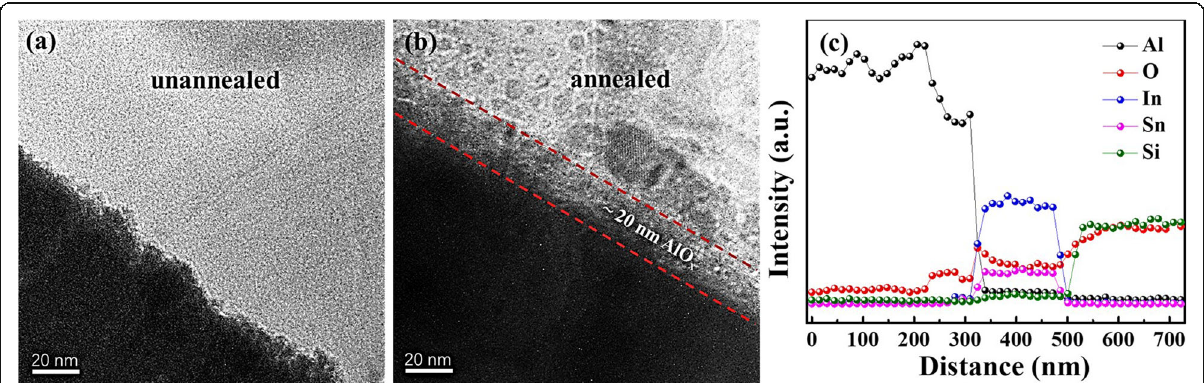
Fig. 2 a Cross-section HRTEM image of the unannealed Pt/Al/ITO. b Cross-section HRTEM image of the annealed sample after 4 h. An interface layer is formed. c The energy dispersive X-ray (EDX) spectra of five elements (Al, O, In, Sn and Si)